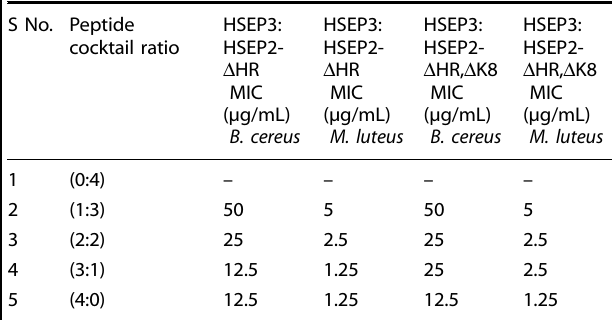
Table 3. MICs for the peptide combinations against B. cereus and M. luteus. MICs were determined as the lowest dilution of the peptide cocktail that inhibited bacterial growth. S No. Peptide cocktail